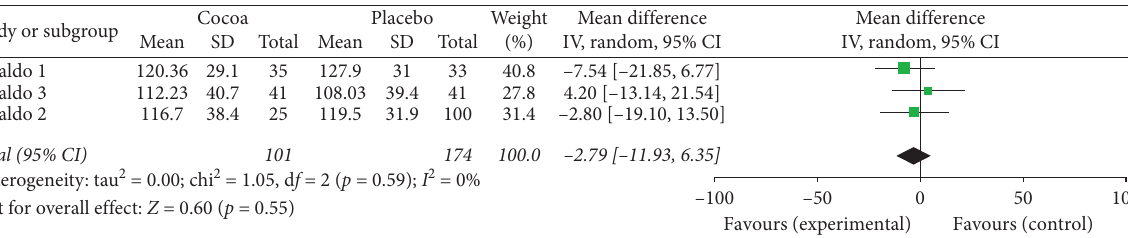
Figure 3: Meta-analysis of the effect of cocoa consumption on LDL cholesterol as compared with placebo. The sizes of the data markers indicate the weight of each study in the analysis. IV: inverse variance.